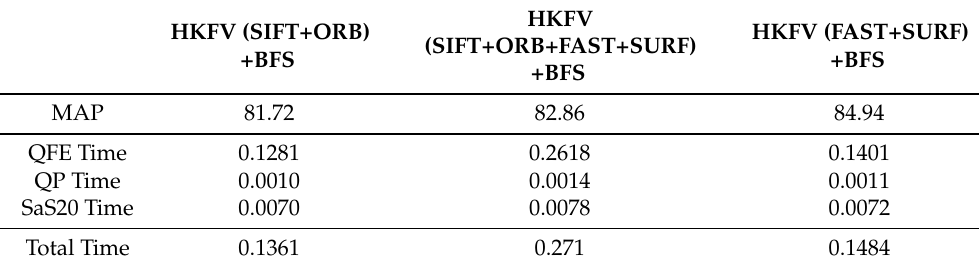
Table 2. Various features combination performance for the proposed method on Oxford Flower-17